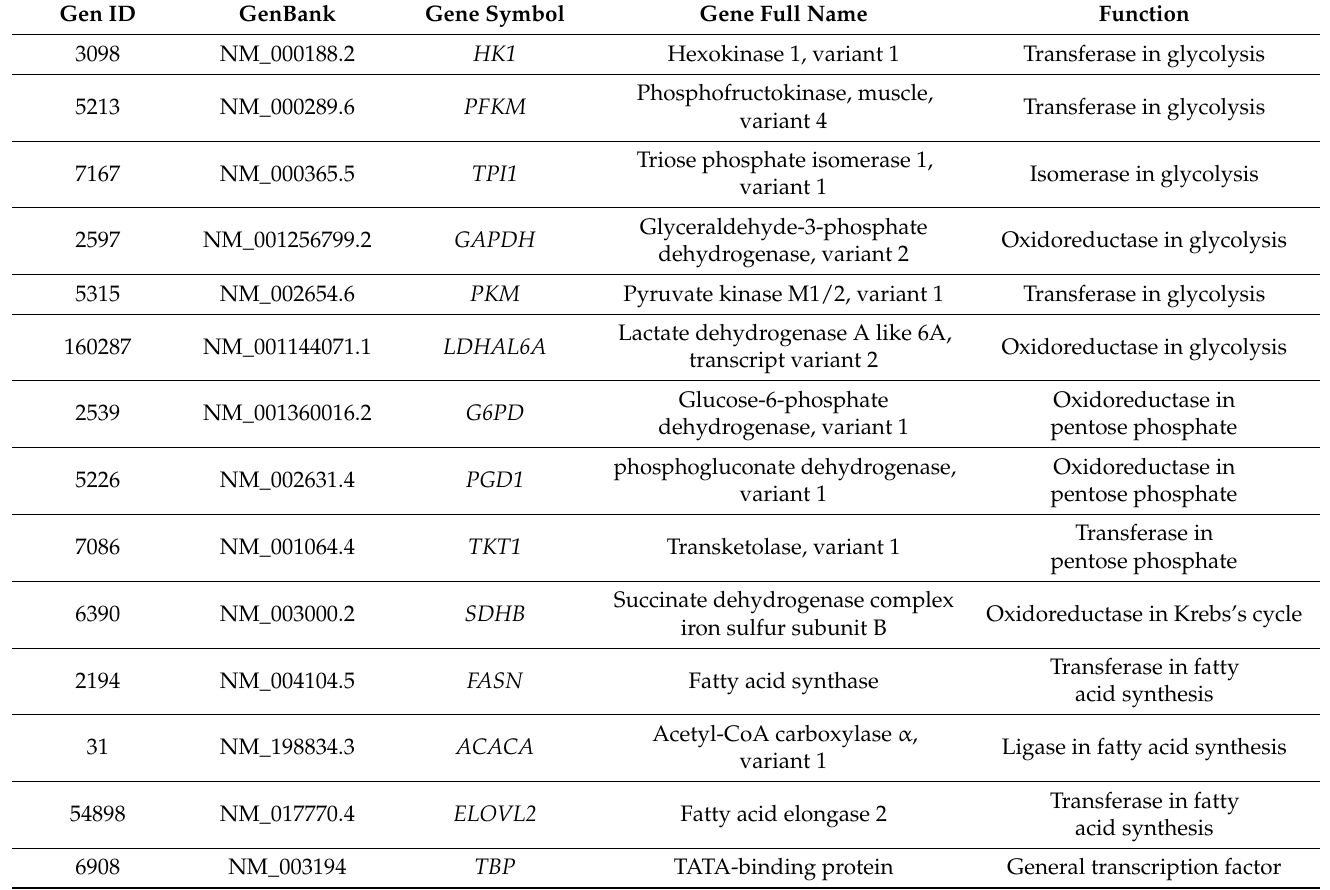
Table 1. Genes analyzed in this